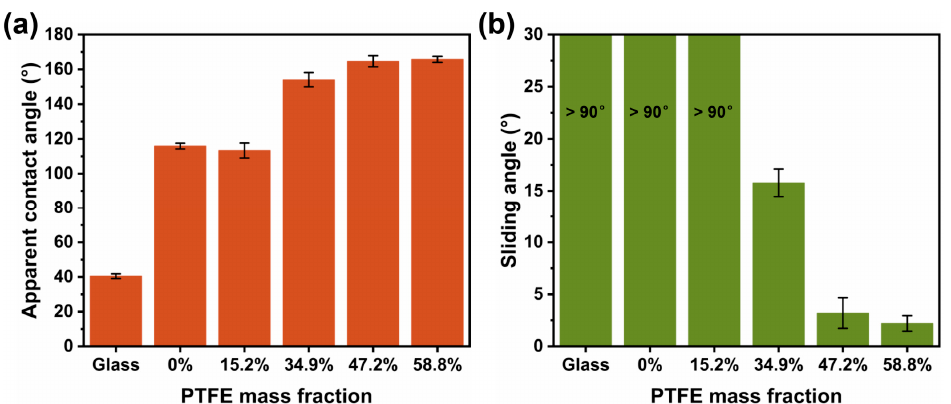
Figure 3. Apparent contact angle ( a ) and sliding angle ( b ) of water droplets placed on glass and coatings with different PTFE mass fractions.